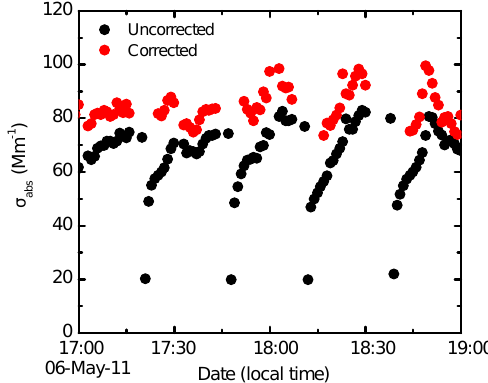
Fig. 3. Median values for vehicular traffic in the JQ tunnel. Hour of the day in local time. The hashed area indicates that at least 50% of the days’ traffic congestions were observed during those hours of the day. Urban cargo vehicles (UCVs), limited to a length of 6.3m, are the only diesel-fuelled vehicles allowed to use the JQ tunnel. Whereas most of the LDVs are flexible fuel vehicles, motorcycles are limited to